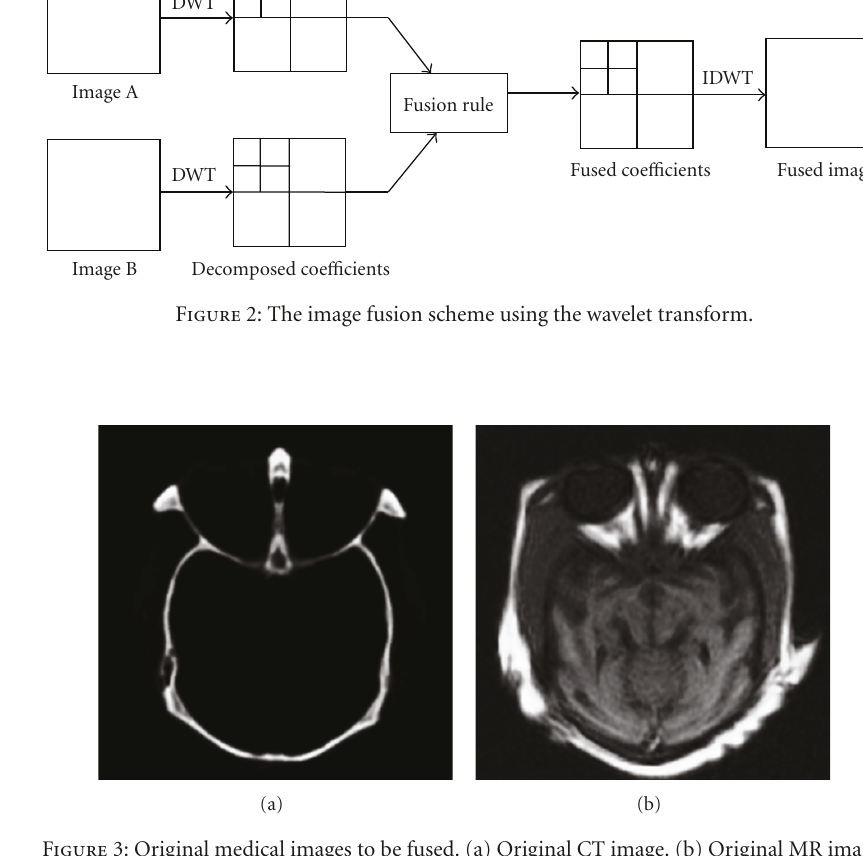
Figure 3: Original medical images to be fused. (a) Original CT image. (b) Original MR